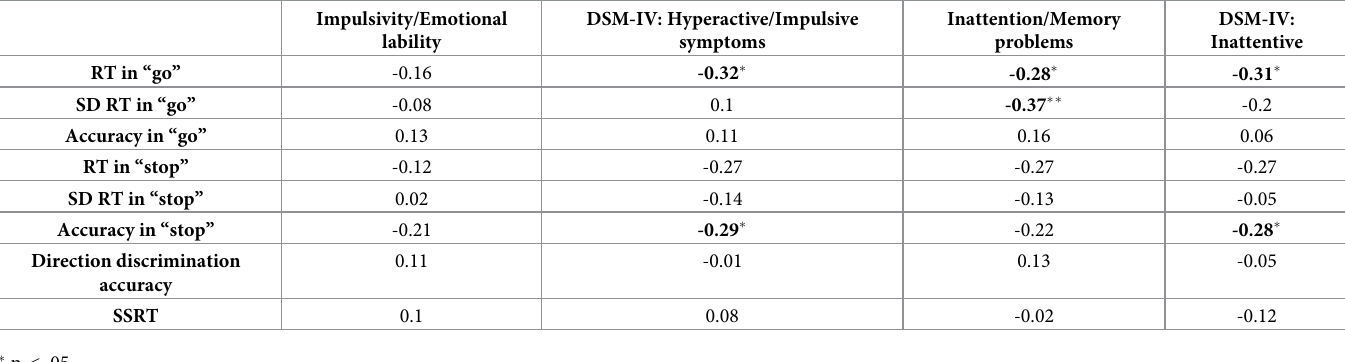
Feature subset selection. As in the first experiment, we used 10-fold cross-validation approach in both keypress and mouse movement conditions. In the keypress condition, for subscale F (DSM-IV: Hyperactive/Impulsive symptoms), the most important predictors were SD RT in “stop” trials and accuracy in “go” trials. For subscale E (DSM-IV: Inattentive symp- toms) most important predictors were accuracy in “go” trials and “stop” trials and mean RT in “stop” trials. toms), the most important predictors were mean maximum velocity in “go” and “stop” trials. in “stop” trials and mean RT in “go” trials. ditions reveals that for both Hyperactive/Impulsive and Inattentive symptoms subscales, fea- tures in mouse movement condition had larger absolute values (Fig 6).